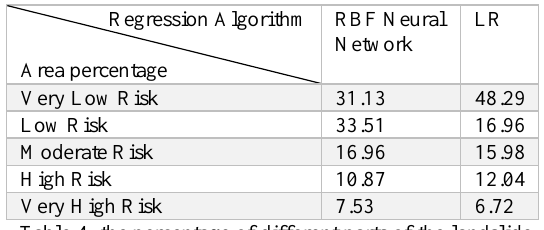
Table 4: the percentage of different parts of the landslide hazard